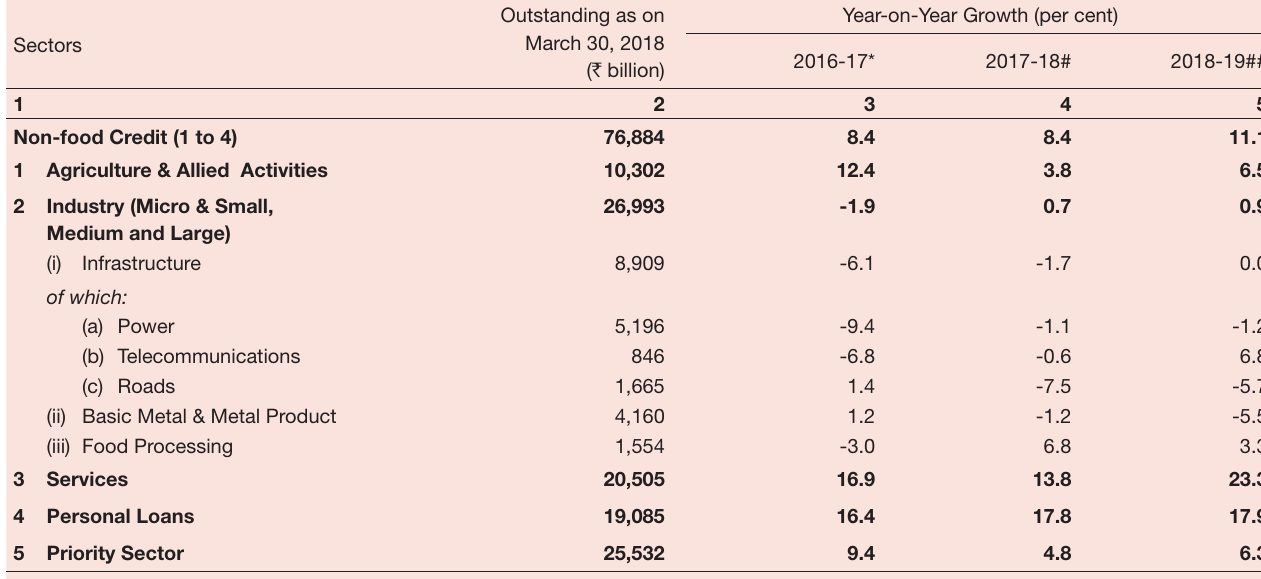
Table II.3.2: credit Deployment to Select